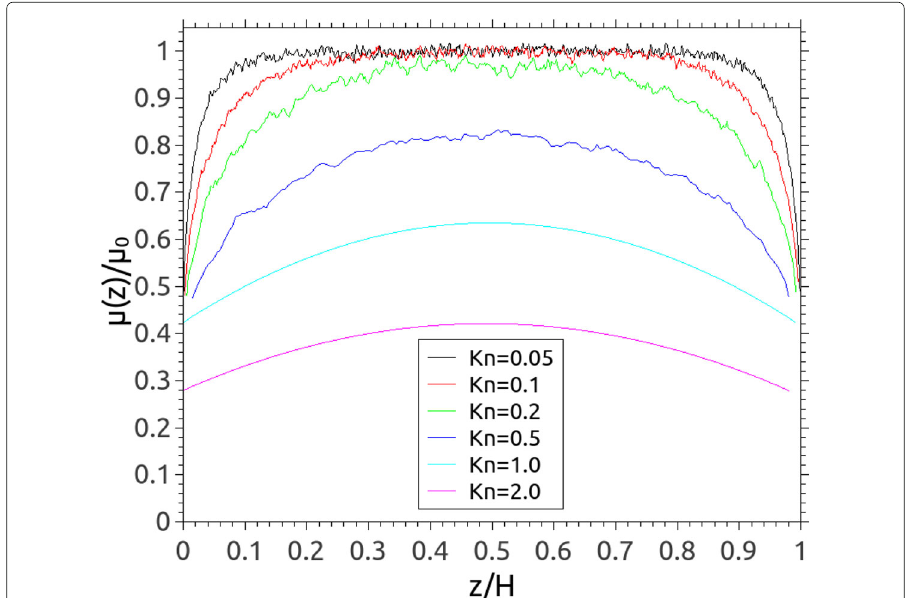
Fig. 5 Spatial variation of the MFP-based viscosity of gases in micro/nanomicrochannels. Note that the viscosity is normalised by the nominal value μ